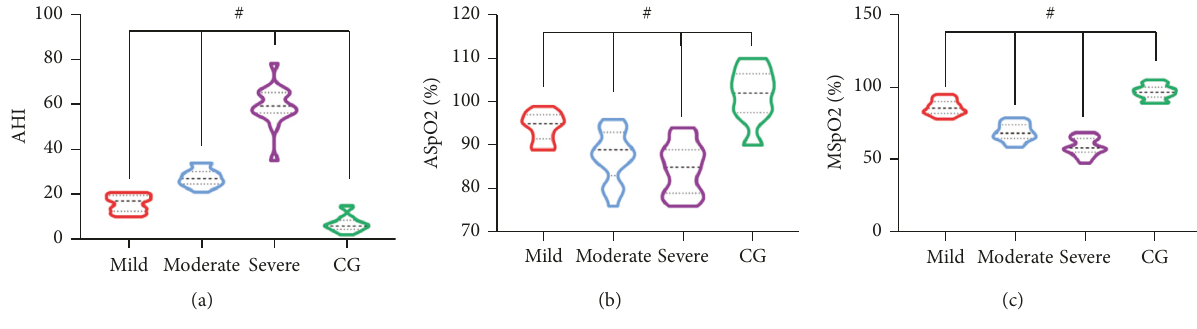
Figure 3: Comparison of PSG-related indicators among groups of patients. Table 6: Correlation analysis of liver and kidney function indicators with PSG indicators in patients with